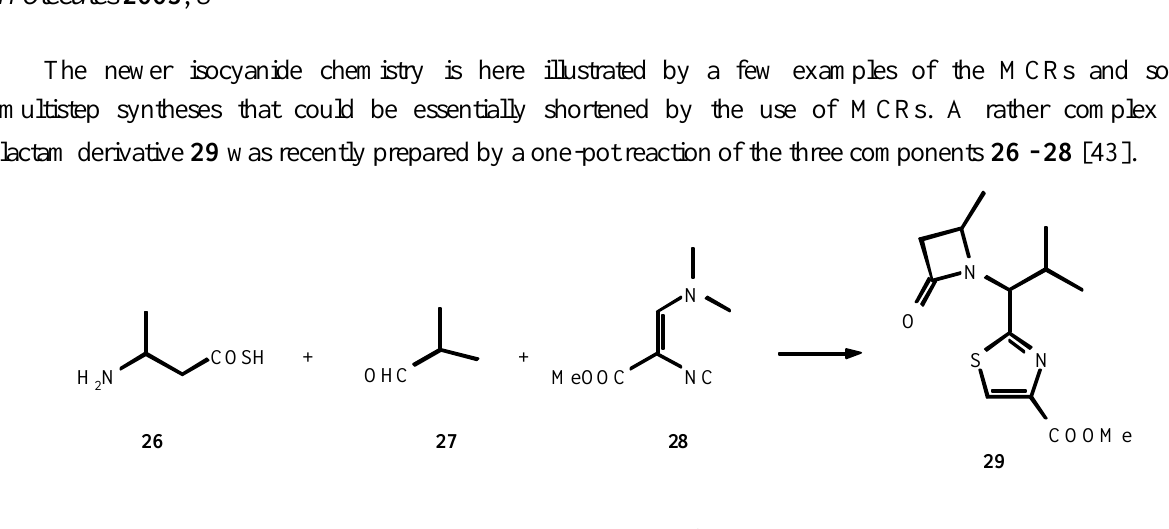
Scheme 8: Synthesis of a complex ß -lactam derivative.